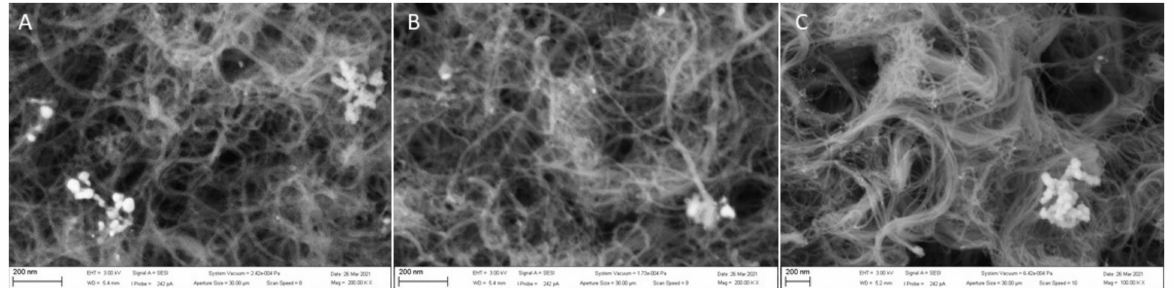
Figure 3. SEM images of the SPCE/MWCNT/NiO0.3 ( A ), SPCE/MWCNT/NiO1.0 ( B ), and SPCE/MWCNT/NiO1.5 ( C ). A scale of 200 nm and a magnitude of 50.00